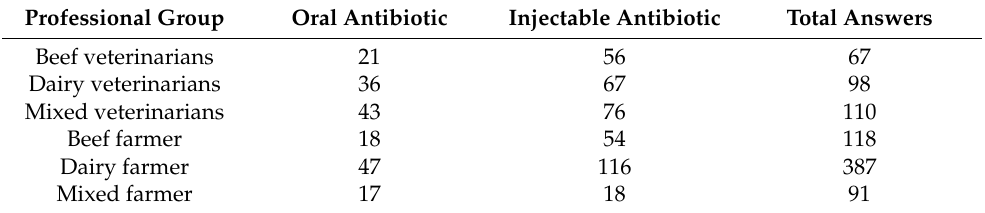
Table 2. Number of participants using oral and injectable antibiotics by occupation and experi- ence.